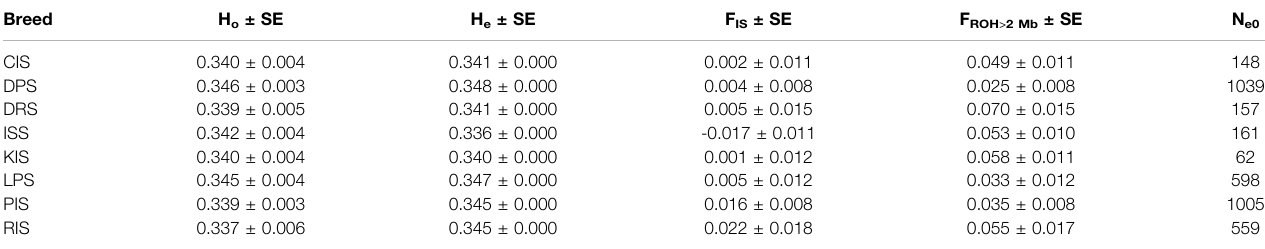
TABLE 1 | Genetic diversity indices for native Croatian sheep breeds. H o , observed heterozygosity; H e , expected heterozygosity; F IS , inbreeding coef fi cient; F ROH > 2 Mb , genomic inbreeding calculated for ROH length over 2 Mb; N e0 , current effective population size. Each breed is represented with a three-letter coding: DRS, Dubrovnik Sheep; LPS, Lika Pramenka; DPS, Dalmatian Pramenka; PIS, Pag Island Sheep; RIS, Rab Island Sheep; CIS, Cres Island Sheep; KIS, Krk Island Sheep; ISS, Istrian Sheep.